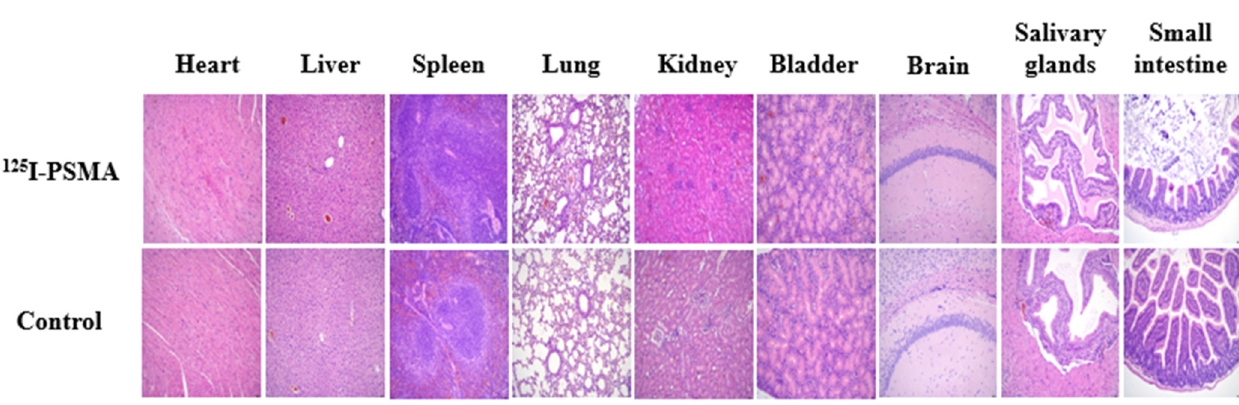
Figure 7. Results of acute toxicity tests on mice. The investigated tissues included the heart, liver, spleen, lung, kidney, bladder, brain, salivary glands, and small intestine. Histopathological analysis of mice by HE staining after a high-dose injection of 125 I-PSMA-7 (top) and normal saline for the control group (bottom).